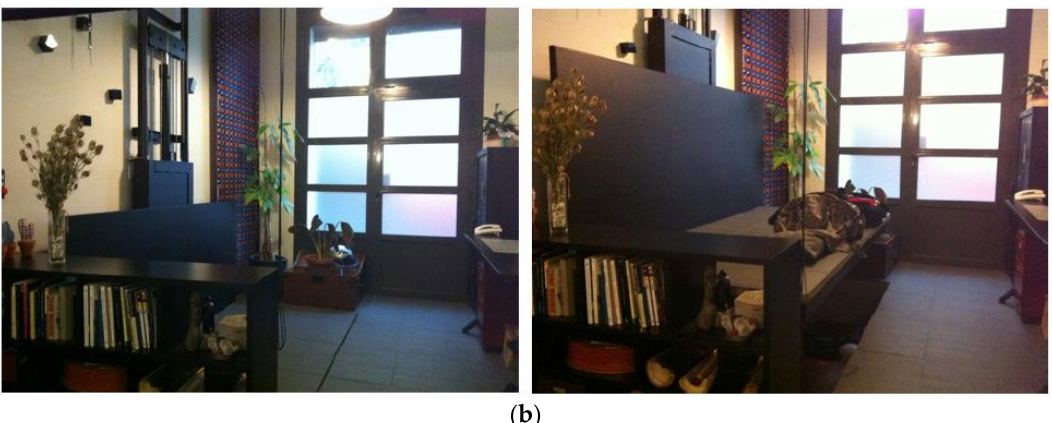
Figure 2. Marta’s house. ( a ) Cross section and floor plan; Legend: (1) entrance hallway; (2) bedroom;